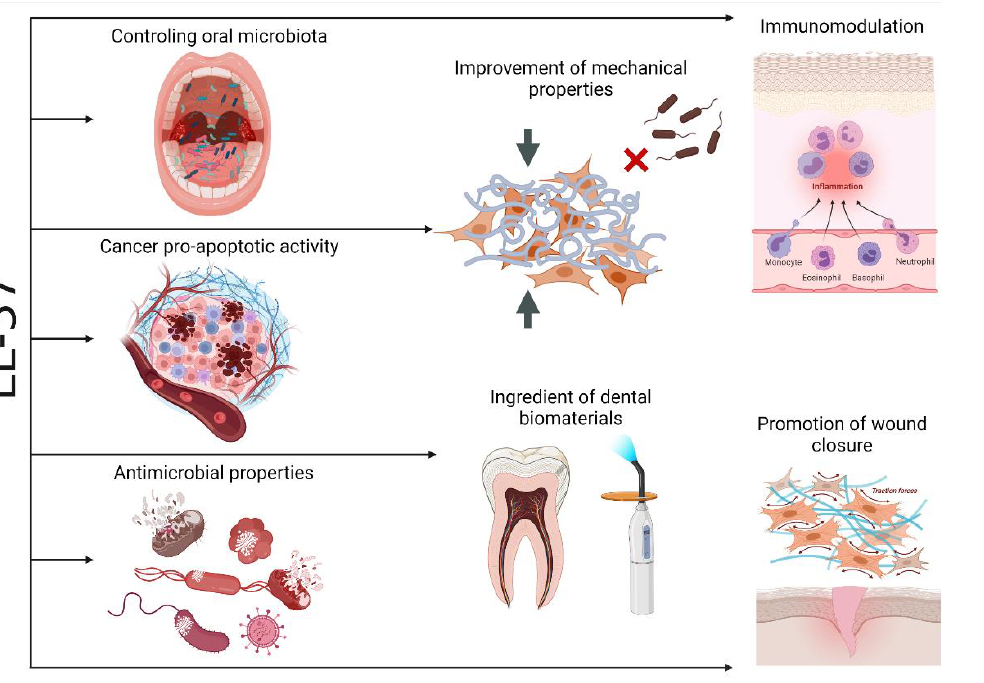
Figure 12. Cathelicidin LL-37 as a pivotal factor in maintaining homeostasis of the oral cavity.